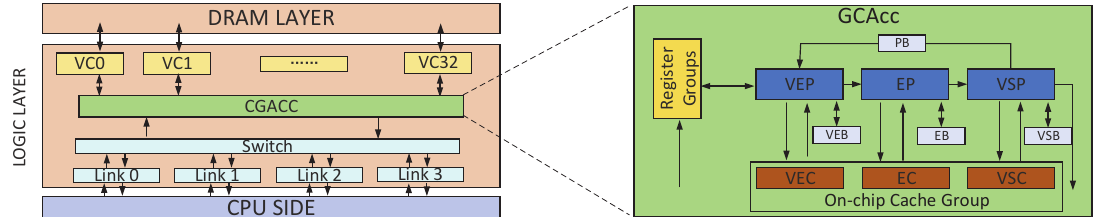
Figure 7. Overview of CGAcc. EB: Edge Buffer; EP: Edge Prefetcher; PB: Prefetch Buffer; VB: Vertex Buffer; VEP: Vertex Prefetcher; VSB: Visited Buffer; VSP: Visited Prefetcher; EC: Edge prefetch Cache; VSC: Visited prefetch Cache.